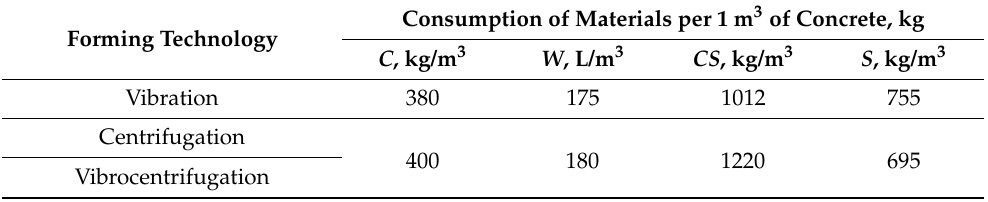
Table 2. Parameters of the composition of concrete mixtures.